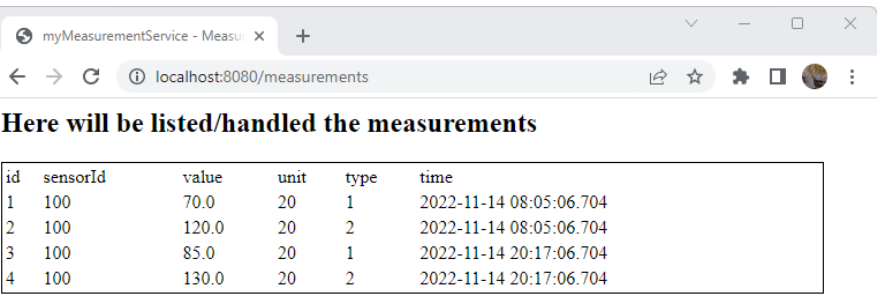
Figure 10. List of